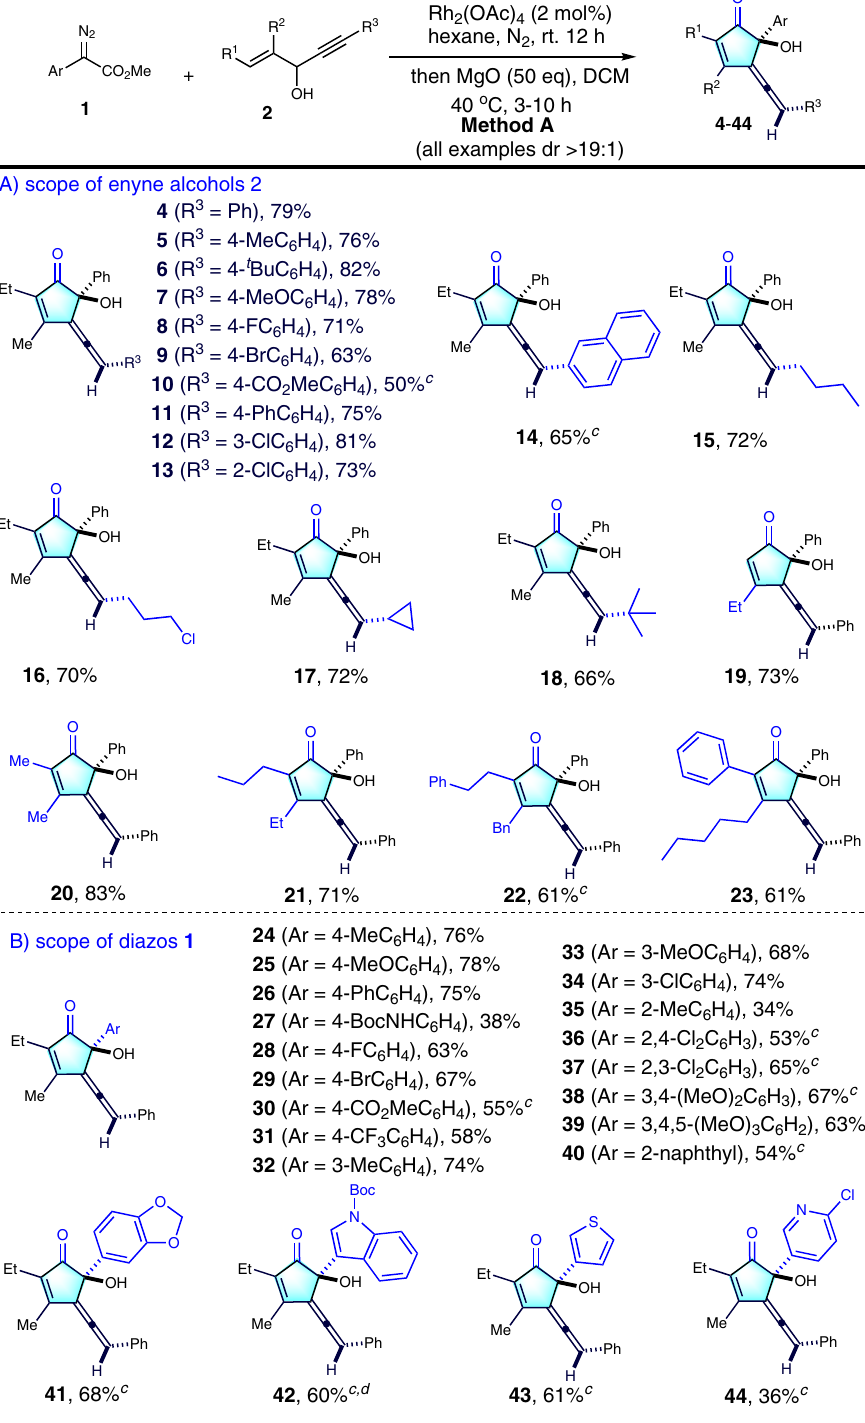
Fig. 3 Racemic version scope of substrates. a Method A: 1 (0.3 mmol, 1.5 eq.), 2 (0.2 mmol, 1eq.) and Rh 2 (OAc) 4 (2 mol%) in hexane (2 mL) stirred at rt. for 12 h under N 2 . Then, to the solution were added MgO (200 mg, 50 eq.), CH 2 Cl 2 (5 mL) and stirred at 40 o C for another 3 h. b Isolated yield, dr > 19:1 (determined by 1 H NMR analysis). c Sovent of fi rst step: (toluene:hexane = 1:1, 2 mL) instead of hexane. d 1 (2.0 eq.) was